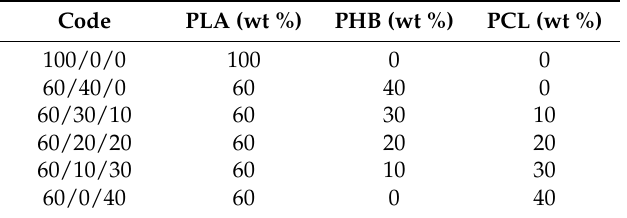
Table 1. Composition and labelling of PLA/PHB/PCL ternary blends.